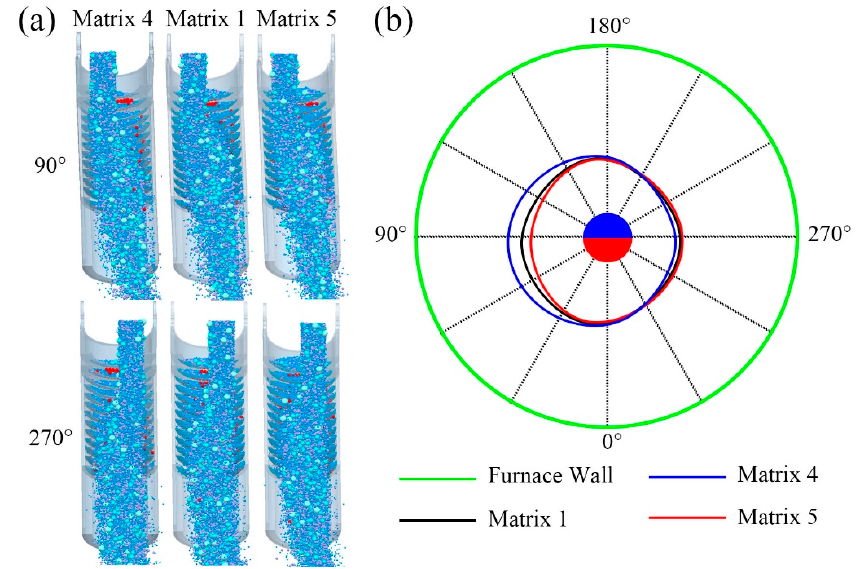
Figure 20. Segregation phenomenon under different cloth matrix by changing the angle of coke and ore in the matrix: ( a ) movement of the charge in the chute with different burden matrices; ( b ) contours of the edge of the ore-free zone with different burden matrices.